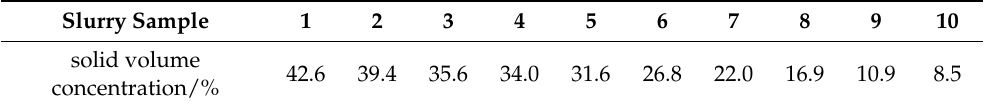
Table 1. Solid volume concentration of the Chengdu clay